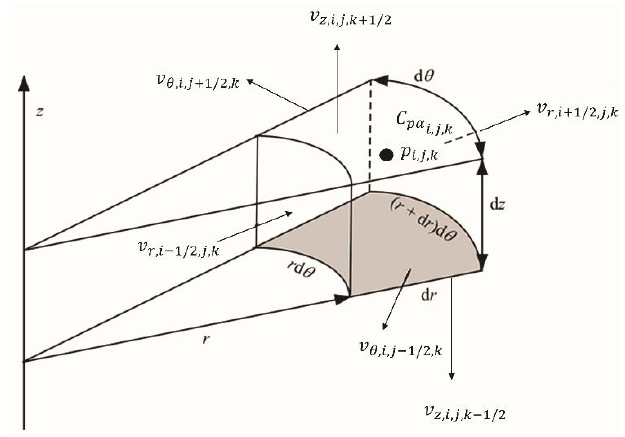
Figure A1. Definition of pressure, velocities, and concentrations on a grid with indices i , j , k . With the definitions of the pressure and velocities in Figure A1, the finite difference approximations of